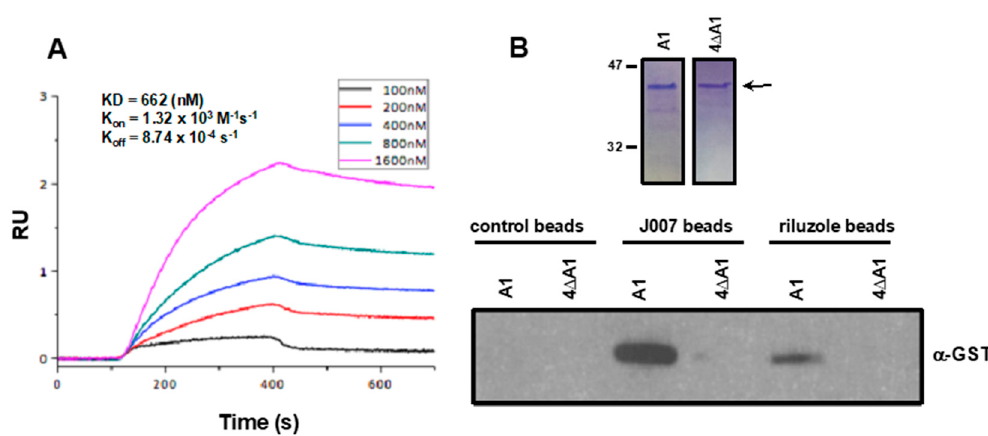
Figure 4. Riluzole interacts directly with hnRNP A1. ( A ) Surface plasmon resonance imaging monitoring the interaction of immobilized hnRNP A1 with riluzole. The KD, K on and K off were calculated by simultaneous non-linear regression using a 1:1 binding model and BIAevaluation 4.1 software. ( B ) Purified GST-tagged native and mutant A1 (4 ∆ A1) hnRNP A1 harboring alanine substitutions at all four critical residues within the hnRNP A1 binding pocket (H120, D123, Y124 and N171) were added to uncross-linked, IRES-J007 and riluzole-crosslinked beads. Native and mutant (4 ∆ A1) were resolved by SDS-PAGE and stained with GelCode™ Blue stain to assess purity (top panel). Binding of native hnRNP A1 to control, IRES-J007 and riluzole coupled beads was detected by immunoblotting with α -GST antibody (bottom panel). Data shown are representative of experiments repeated twice.